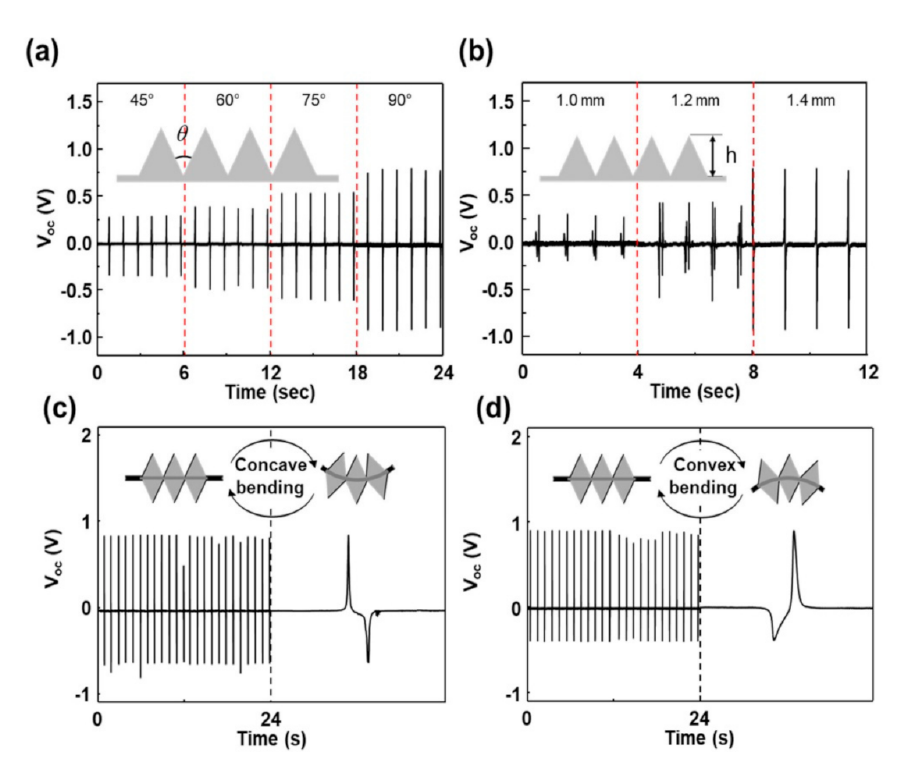
Figure 2. ( a ) Output voltages of the sensor with different angles between triangles. ( b ) Output voltages of the sensor with different height. Output voltages of both sides sensors with ( c ) concave bending and ( d ) convex